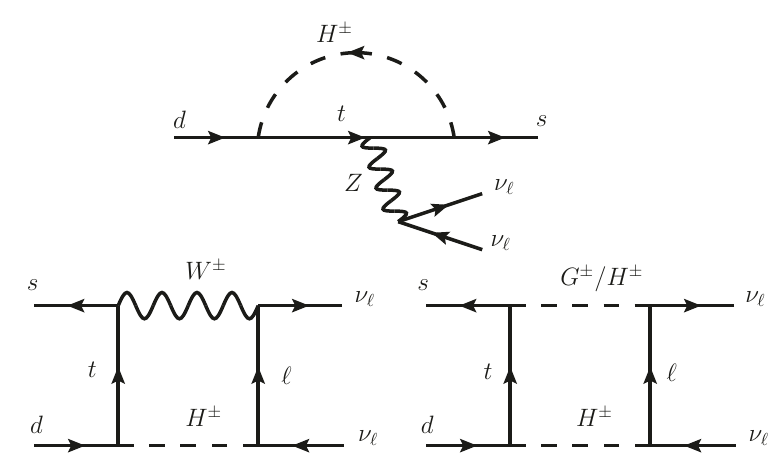
Figure 2 . Sketched Feynman diagrams for the K